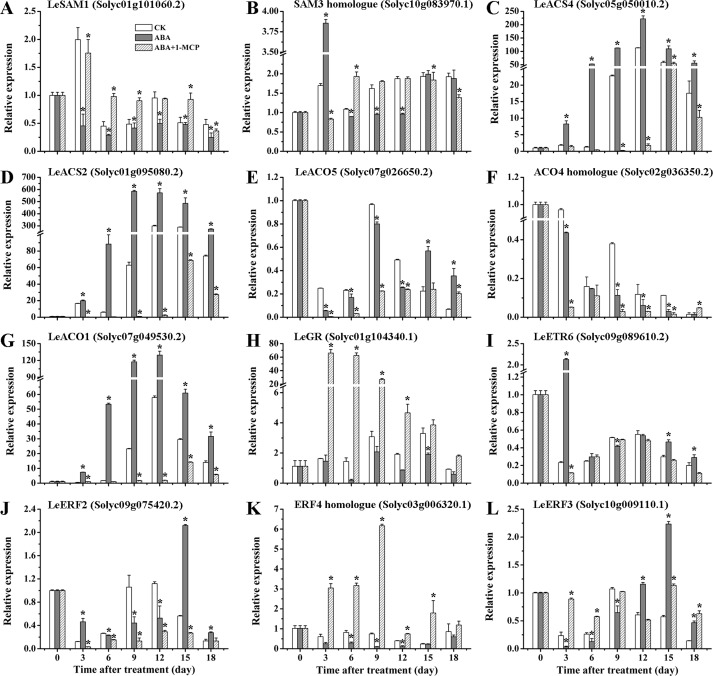
The expression of DEGs related to ethylene biosynthesis and signaling in CK, ABA and (ABA+1-MCP)-treated fruits at different ripening stages.RT-PCR analysis of SAM1 (A), SAM3 (B), ACS1 (C), ACS2 (D), ACO1 (E), ACO4;1 (F), ACO4;2 (G), RTE1 (H), ETR2 (I), EBP (J), ERF4;1 (K) and ERF4;2 (L) were conducted in CK vs ABA and CK vs ABA+1-MCP treatment. Other details are the same as in Fig 5.